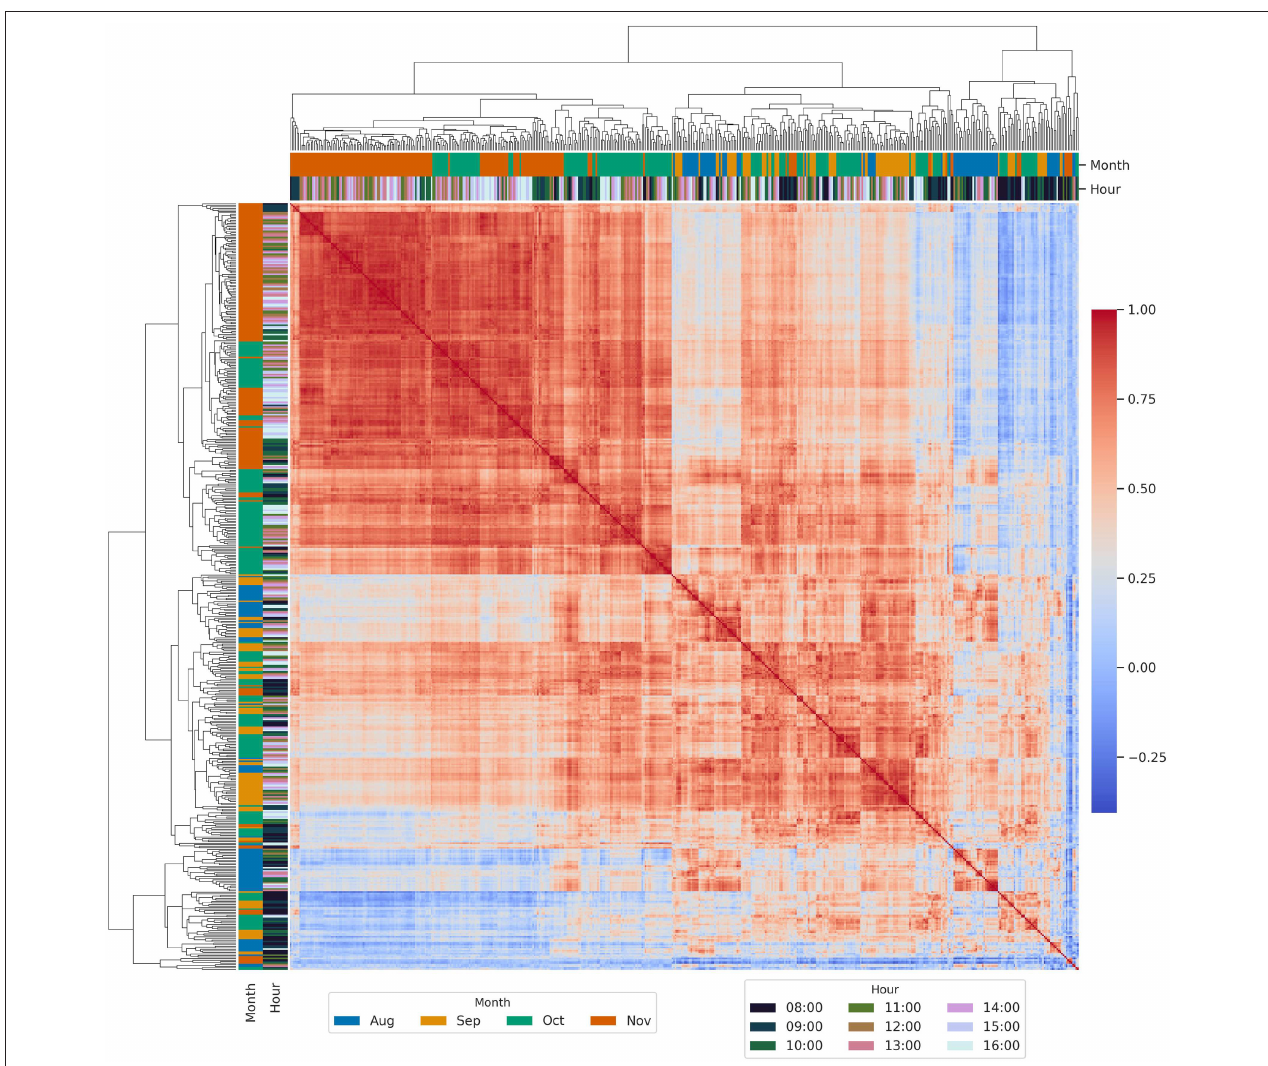
FIGURE 4 | Hierarchically-clustered heatmap of all possible pairwise phenotypic correlations between best linear unbiased predictors of genotype effects (BLUPs) for ArduCrop canopy temperature in 2016. Frequency distributions of the phenotypic correlations are shown in Figure S11 .